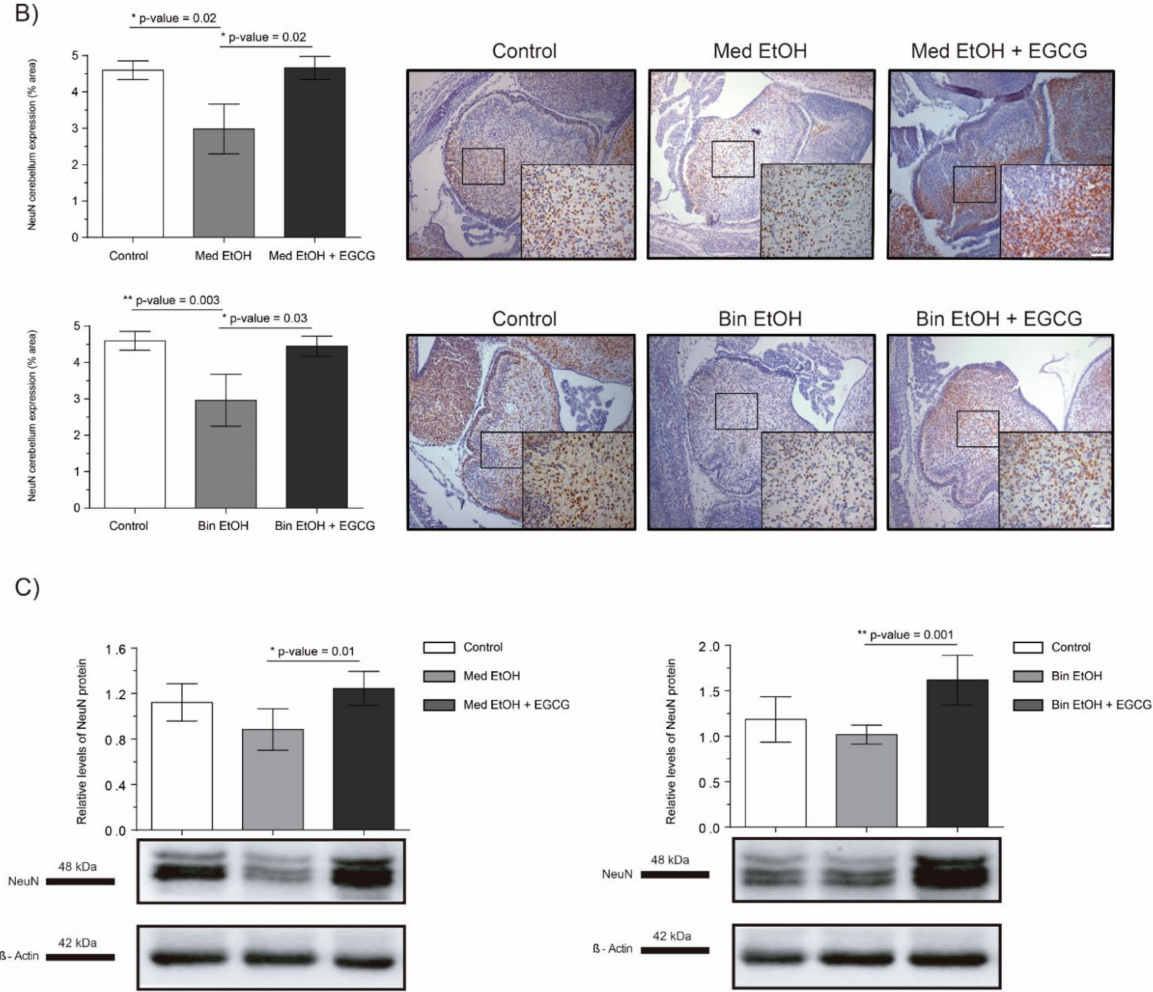
Figure 6. Representative neuronal nuclear antigen (NeuN) immunostaining in the dentate gyrus ( A ) and cerebellum ( B ), and NeuN protein analysis in whole brain lysed samples by Western blot ( C ) for PAE and EGCG treatment for the binge and Mediterranean patterns. ( A ) NeuN + cell quantification in whole sections of the dentate gyrus using a 10 × objective lens, ( B ) NeuN + cell quantification in cerebellum sections in two different microscopic fields using a 40 × objective lens, and ( C ) Representative Western blot of NeuN expression observed in all analyzed samples under the various experimental conditions. Protein levels were normalized using α -tubulin as load control. Arbitrary units express “fold change”. At least five samples from different litters were used from each group. For intergroup comparisons, the Kruskal–Wallis test (Dunn’s test for multiple comparisons) was used. Asterisks denote the level of significance: * p -value < 0.05, ** p -value <